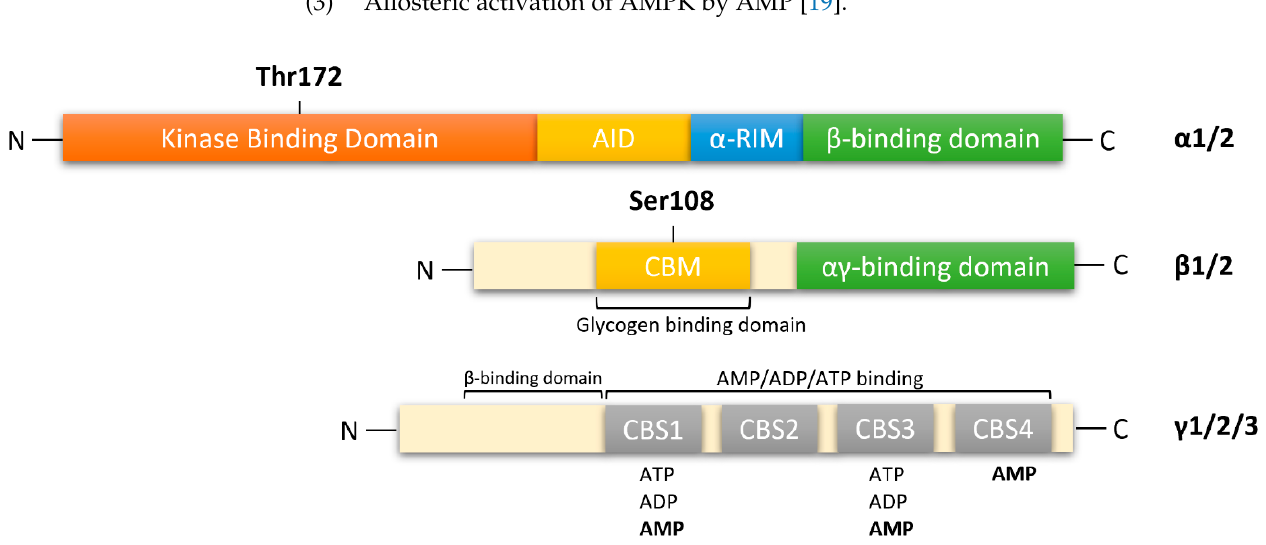
Figure 1. Functional domain of AMPK subunits. AMPK is a heterotrimeric complex composed of a catalytic α subunit( α 1/2), regulatory β subunit ( β 1/2), and γ ( γ 1/2/3) subunit. AMPK α : kinase domain (KD) at the N-terminal contains Thr172, which is phosphorylated by upstream kinases; AID, auto-inhibitory domain; α -RIM: regulatory subunit interacting motif triggering conformational changes; β -subunit binding domain at the C-terminal. AMPK β subunit: carbohydrate-binding module (CBM) near the N-terminal contains Ser108, which is important for the mechanism of action of some direct activators of AMPK; C-terminal domain containing the α -subunit-binding site and immediately followed by the domain for the γ -subunit interaction. αγ -binding domain: α -subunit-binding and γ -subunit interaction site at the C-terminal. AMPK γ subunit: cystathione- β -synthases (CBS) domain, which forms two Bateman domains containing four ATP/ADP/AMP-binding sites (CBS1–4).